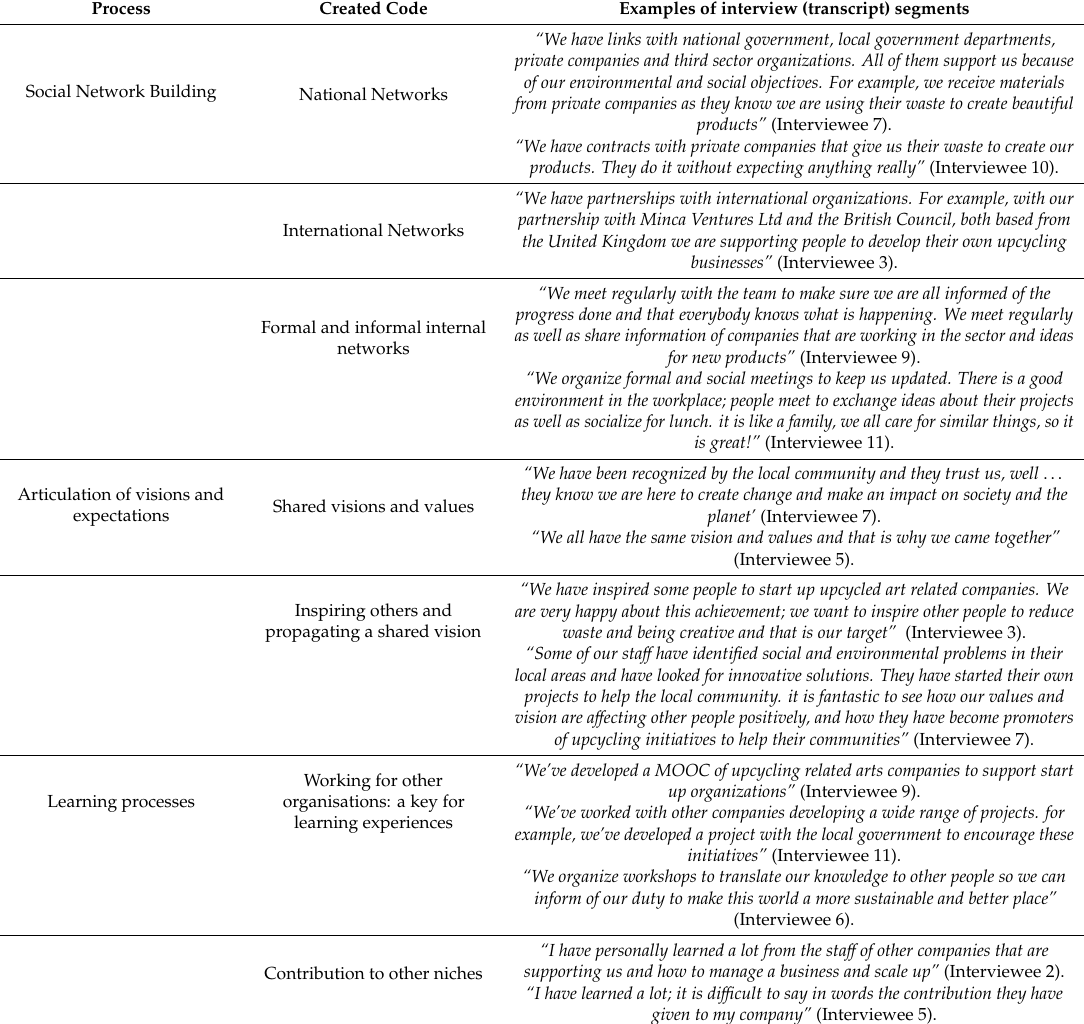
Table 6. Indicators and values of the theoretical